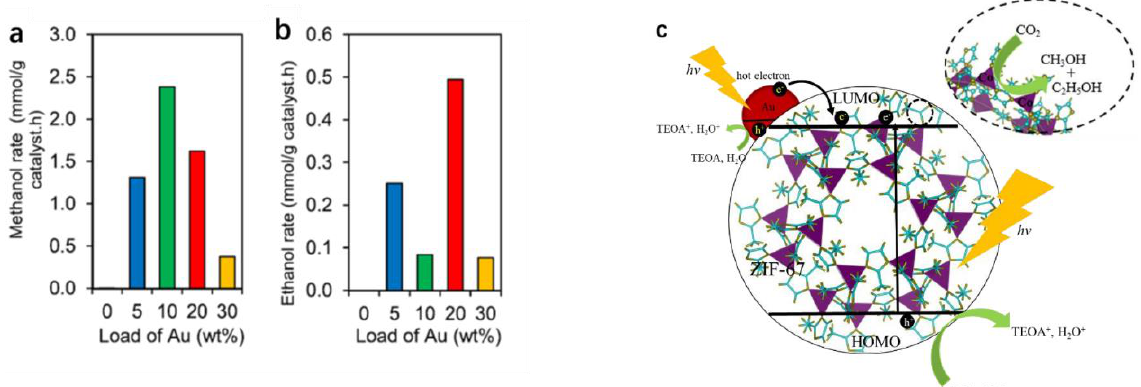
Figure 10. ( a , b ) Effects of loading of Au on the photocatalytic activity of Au/ZIF-67 in a photocata- lytic CO 2 reduction. ( c ) Proposed mechanism for photocatalytic CO 2 reduction to methanol and eth- anol over Au/ZIF-67. Reproduced with permission from reference [83].